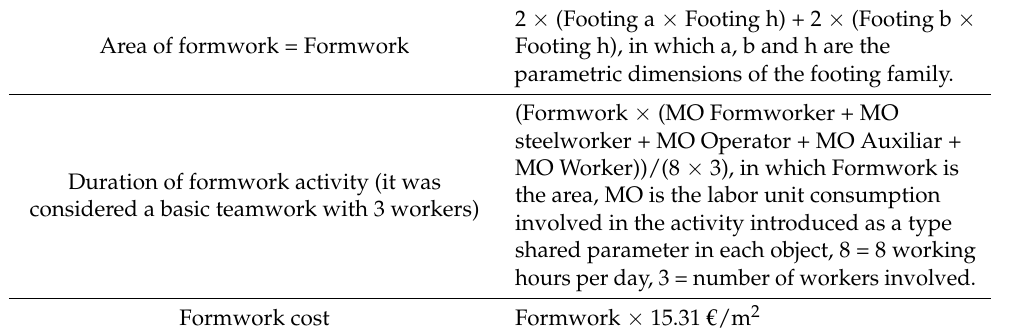
Table 1. Formwork parameters